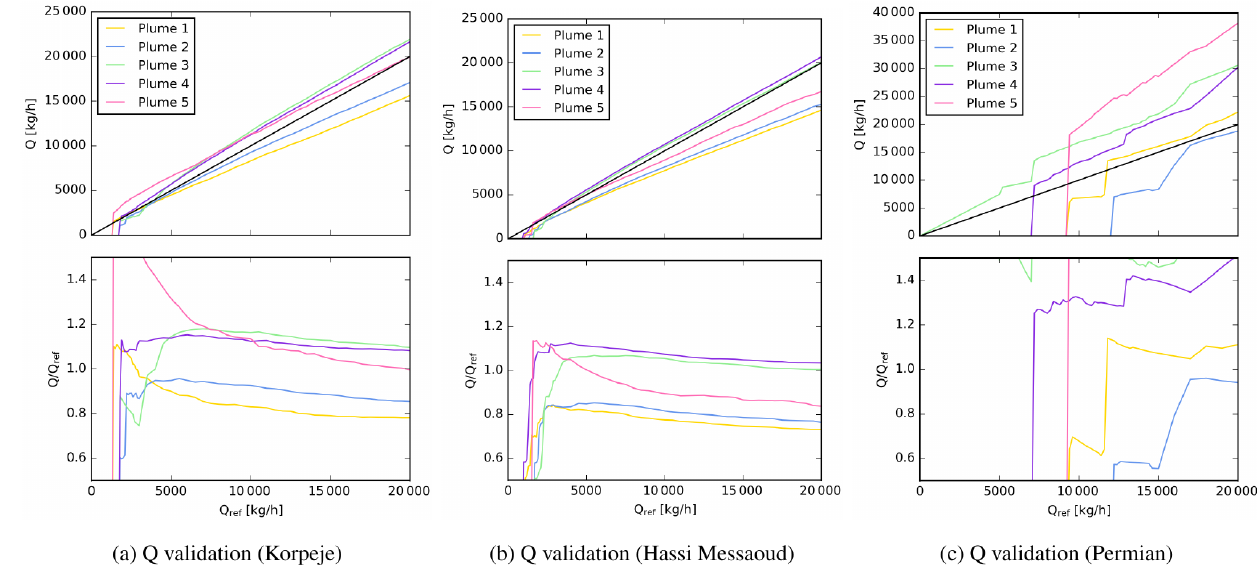
Figure 10. Q validation against reference values for a variety of plume shapes with a supervised detection masking criteria as detailed in Sect.